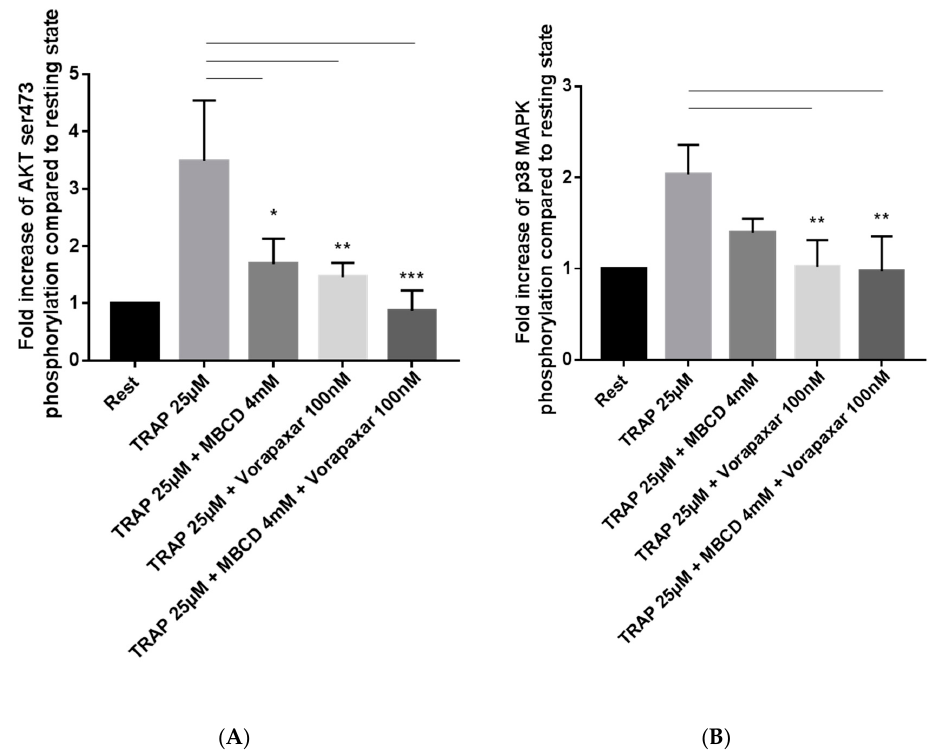
Figure 4. Effect of MBCD and vorapaxar on Akt and p38 MAP kinase phosphorylation following TRAP activation. ( A ) TRAP (25 µM)-induced phosphorylation of Akt on Ser 473 was significantly decreased in MBCD-treated platelets. As expected, vorapaxar (100 nM) strongly impaired the phosphorylation of Akt on Ser 473 following TRAP activation. The association of vorapaxar and MBCD treatment abolished TRAP-induced Akt phosphorylation on Ser473. ( B ) MBCD treatment tended to decrease the phosphorylation of p38 MAP kinase in TRAP (25 µ M)-activated platelets. Vorapaxar (100 nM) significantly inhibited TRAP-induced p38 MAP kinase phosphorylation. Results are mean ± SEM from four independent experiments. * p < 0.05, ** p < 0.01, ***, p < 0.001 according to one-way ANOVA. MBCD: methyl β cyclodextrin, TRAP: thrombin receptor-activating